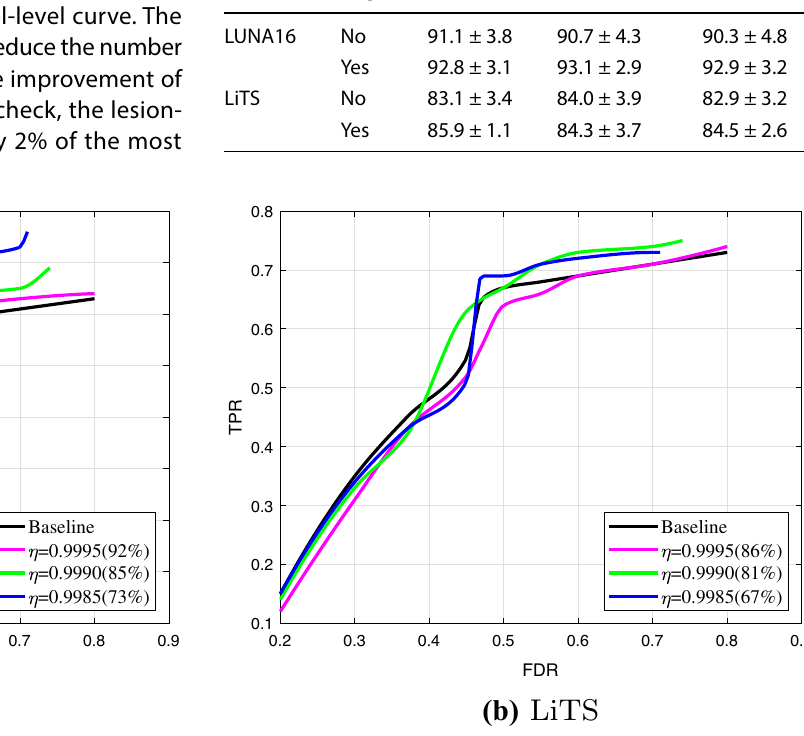
Fig. 3 ROC curves of lesion-level performance on the retained predictions for different uncertainty thresholds. Percentage in the brackets shows ratio of lesions retained at that particular thresh-